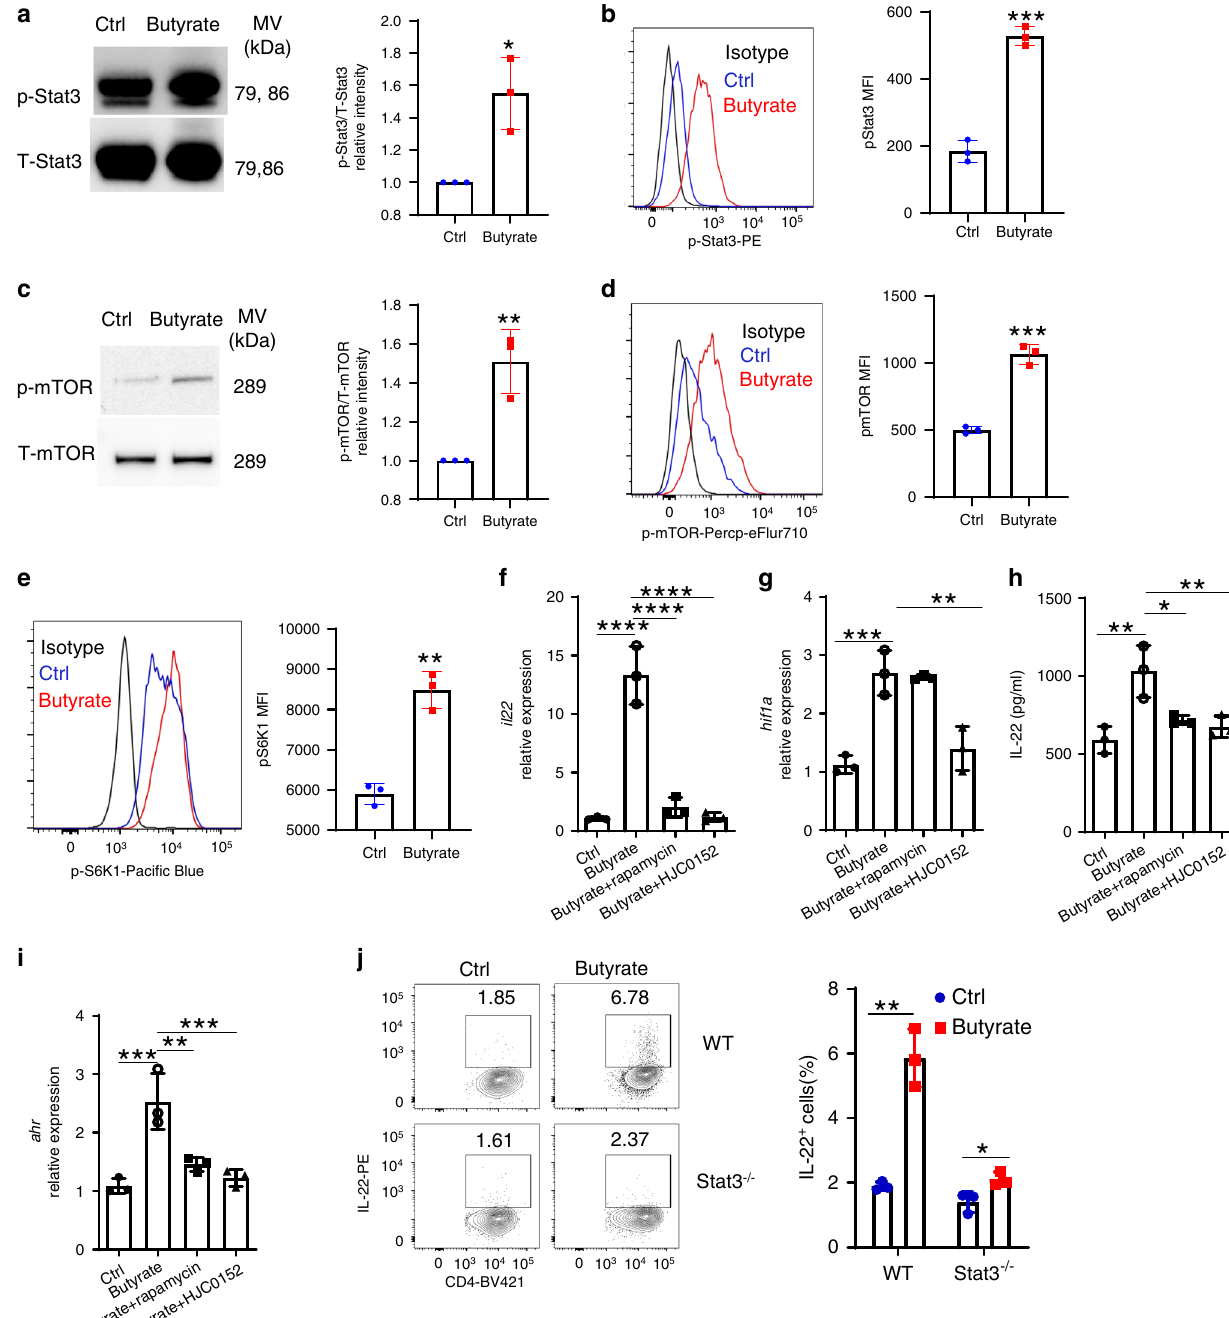
Fig. 5 Stat3 and mTOR regulate IL-22 production by CD4 + T cells. a – d WT CD4 + T cells were activated with anti-CD3/CD28 mAbs under Th1 conditions with or without butyrate (0.5 mM) ( n = 3/group). Phosphorylated Stat3 (6 h) ( a , b ) and phosphorylated mTOR (24 h) ( c , d ) were assessed by western blot and fl ow cytometry. Phosphorylated S6K was analyzed by fl ow cytometry ( e ). f – i CBir1 Tg CD4 + T cells were activated with APCs and CBir1 peptide under Th1 conditions with butyrate (0.5 mM) ± rapamycin (1 µ M) or HJC0152 (1 µ M). IL-22 mRNA ( f ) and protein ( g ) were assessed by qRT-PCR and ELISA at 60 h ( n = 3/group). Expression of Hif1a ( h ) and Ahr ( i ) was analyzed at 48 h by qRT-PCR. j WT and Stat3 − / − CD4 + T cells were treated with or without butyrate (0.5 mM) for 5 days ( n = 3/group). IL-22 production was measured by fl ow cytometry. One representative of three independent experiments was shown. Data were expressed as mean ± SD. Statistical signi fi cance was tested by two-tailed unpaired Student t -test ( a – e , j ) or two-tailed one-way ANOVA ( f – i ). a * p = 0.0134; b *** p = 0.0002; c ** p = 0.0059; d *** p = 0.0002; e ** p = 0.0010; f , **** p < 0.0001; g ** p = 0.0019 (butyrate vs control) and 0.0069 (butyrate + rapamycin vs butyrate), * p = 0.0141; h *** p = 0.0004, ** p = 0.0012; i , *** p = 0.0004 (butyrate vs control) and 0.009 (butyrate + HJC0152 vs butyrate), ** p = 0.0030; j ** p = 0.0017, * p =